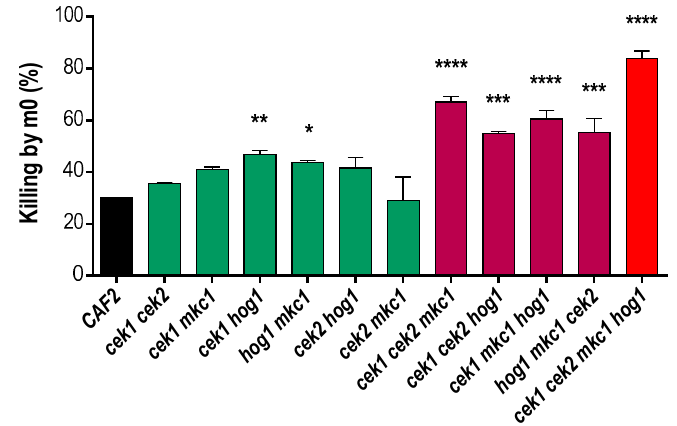
Figure 2. Susceptibility of MAPK mutants to macrophage-mediated killing. Yeast cells were added to a confluent monolayer of murine macrophages from cell line RAW 264.7 at MOI 1:20 (yeast:m0) and co-incubated for 4 h at 37 °C and 5% CO 2 . Killing percentages were assessed after CFU counting of fungal cells obtained upon interaction and related to fungal cells assayed without macrophages (positive control–0% killing). All strains were normalized to the wild type (CAF2) with a given value of 30% killing. Error bars represent the standard deviation of duplicates. * p < 0.05; ** p < 0.01; *** p < 0.001; **** p < 0.0001 (one-way ANOVA, multiple comparison tests related to CAF2).